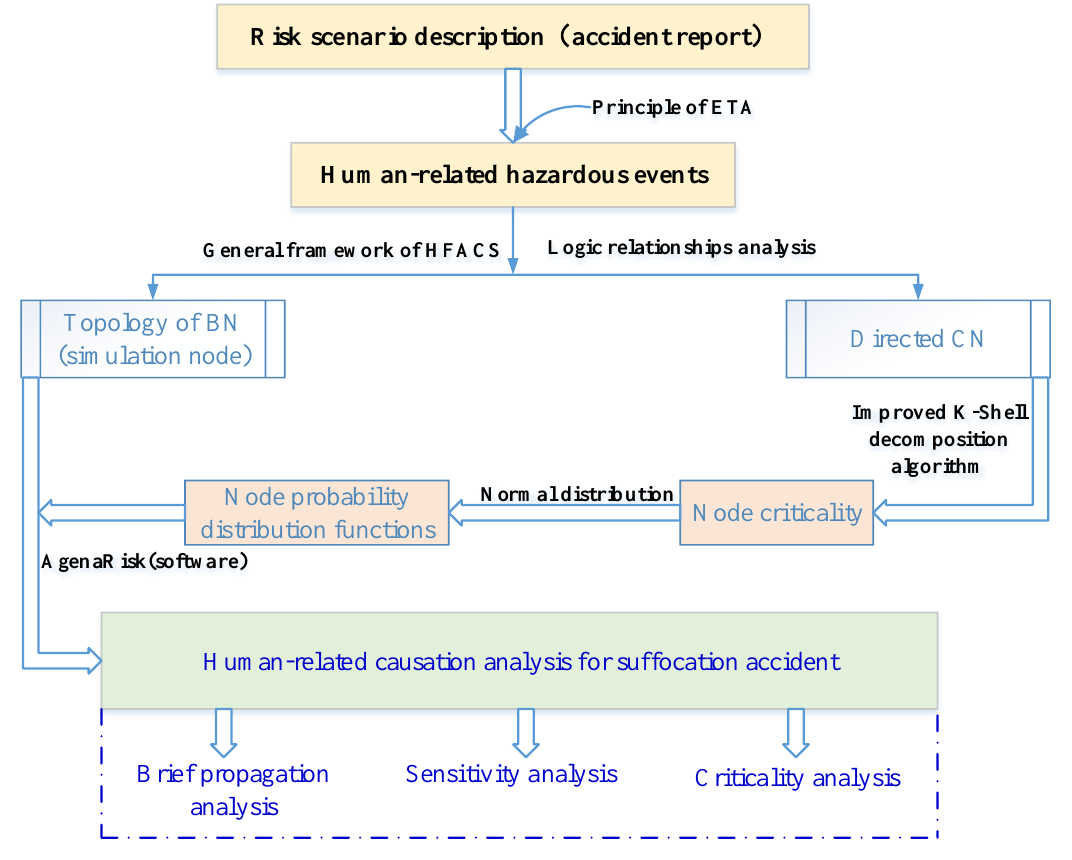
Figure 1. Overview for the proposed methodology.